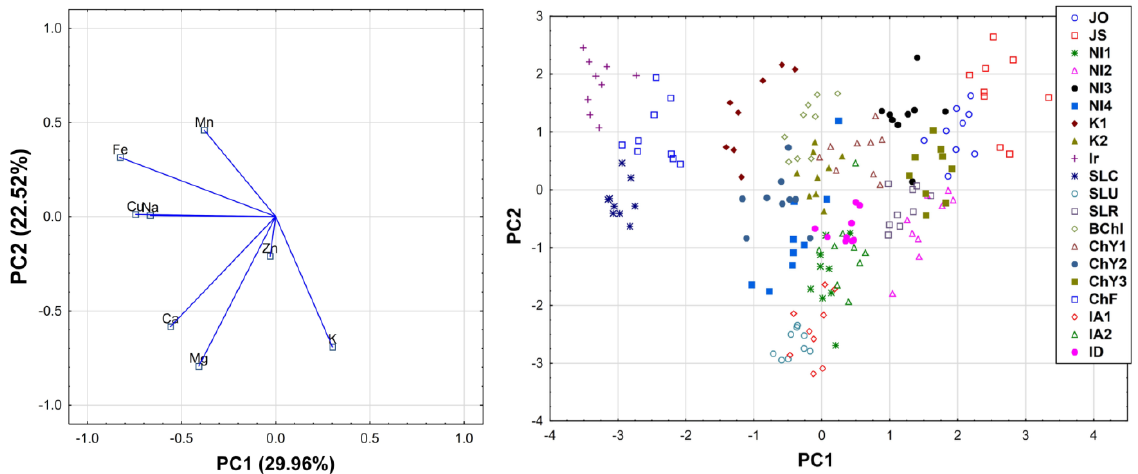
Figure 1. Loadings (on the left ) and scores (on the right ) of first two components of principal component analysis (PCA).